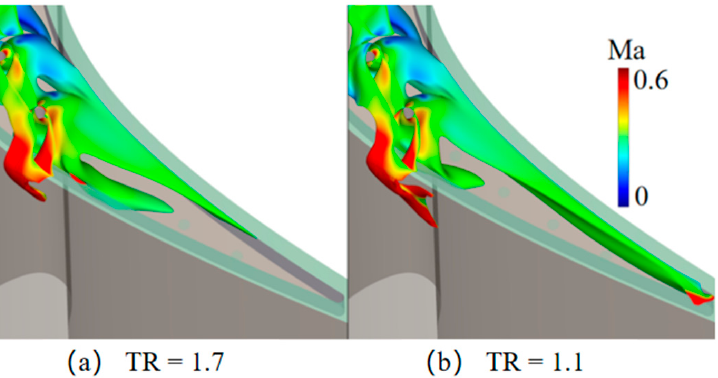
Figure 10. Isosurface of the coolant mass fraction ( η = 0.27) under TR = 1.7 and TR = 1.1, colored by Mach number.